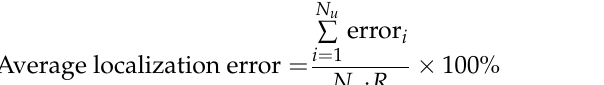
Figure 10. Comparison of various localization algorithms with different anchor node ratio: localiza- tion error.